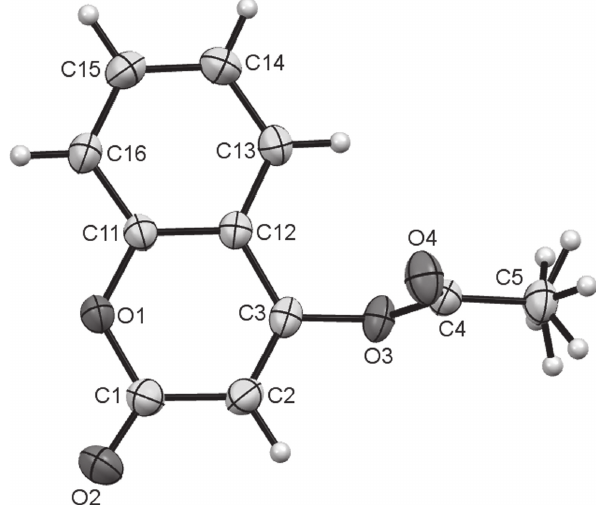
Table 1: Data collection and handling.